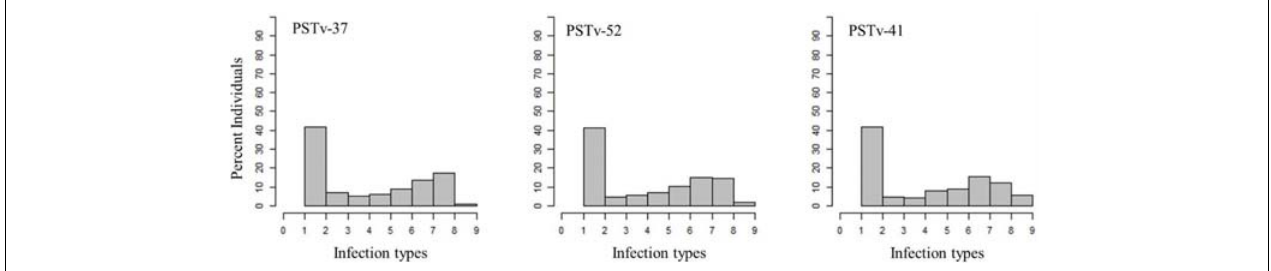
FIGURE 2 | Distributions of the seedling responses of the durum wheat genotypes to Puccinia striiformis f. sp. tritici races PSTv-37, PSTv-41, and PSTv-52.